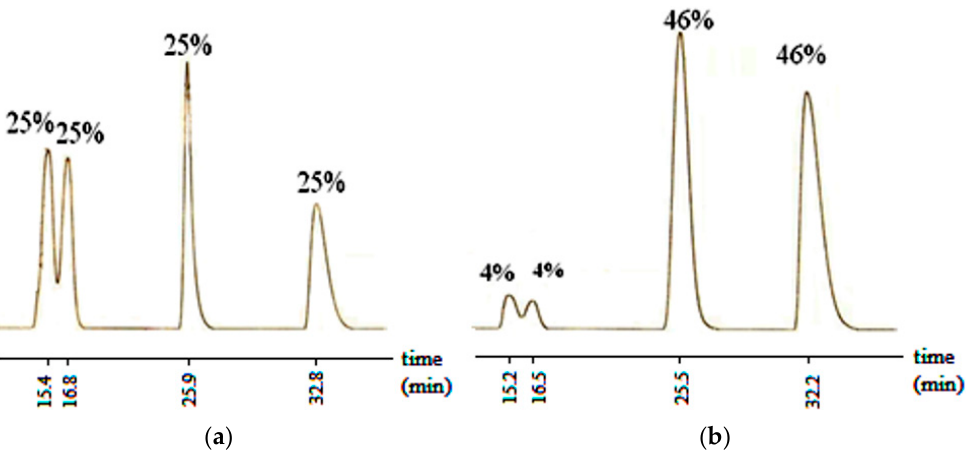
Figure 1. HPLC chromatogram of 6 showing the isomer compositions ( a ) at the end of the reaction; and ( b ) after recrystallization from ethyl acetate-hexane. (Column: Chiralpak IB, Eluent ( v / v ) hexane: ethanol (95:5), flow rate: 0.7 mL/min).